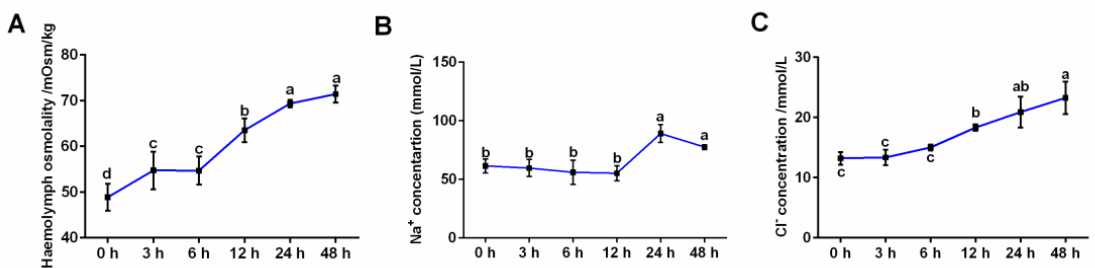
Figure 1. Effects of salinity stress on hemolymph and ion concentrations. ( A ) Hemolymph osmolality; ( B ) Na + concentration in the hemolymph; ( C ) Cl - concentration in the hemolymph. Data were expressed as mean ± SD ( n = 6). Different letters indicate statistical differences ( p < 0.05) between groups.